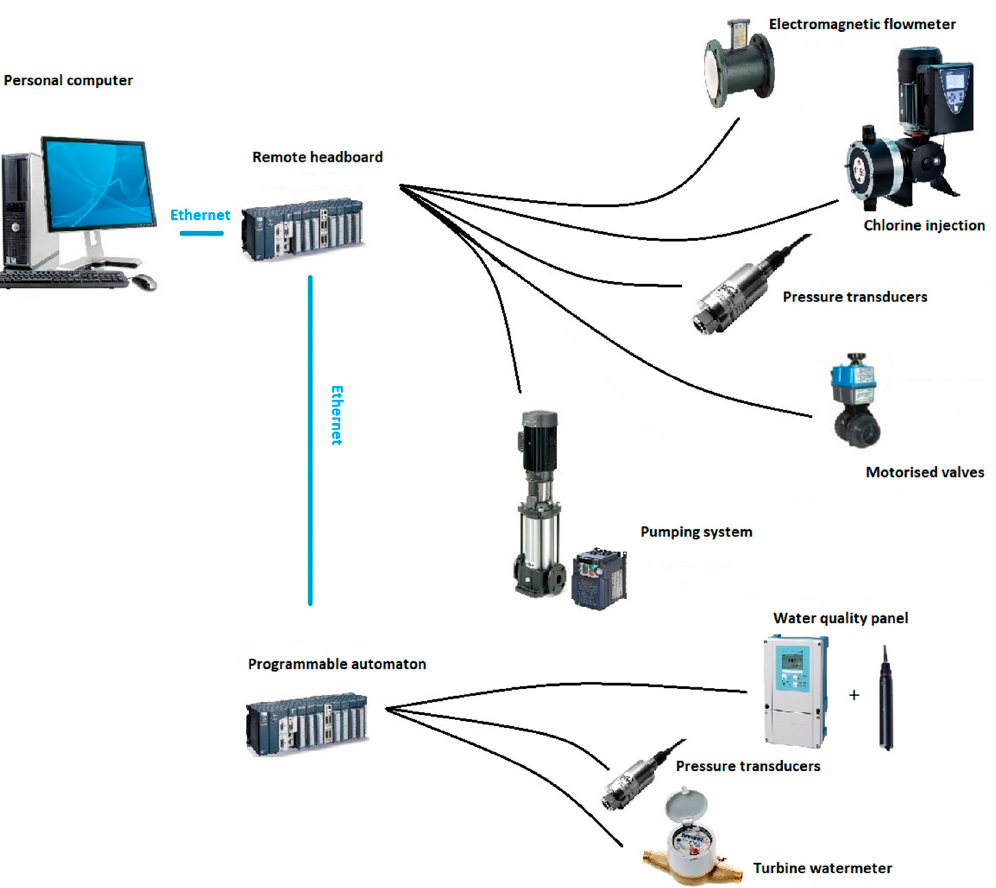
Figure 3. Communication network of the supervisory control and data acquisition (SCADA) system developed.